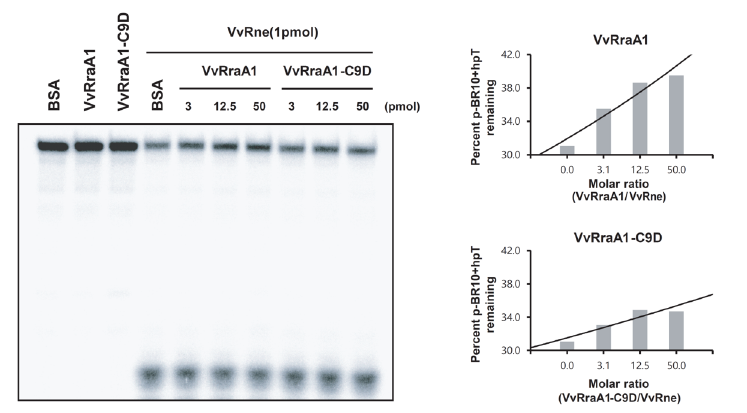
Fig 5. Inhibition of VvRraA1 and VvRraA1-C9D on the cleavage of p-BR10+hpT by VvRNase E in vitro . 0.5 pmol of 5’-end-labeled p-BR10+hpT RNA was incubated with 1 pmol of VvRne with varying concentrations of VvRraA1 and VvRraA1-C9D, 50 pmol of VvRraA1, or 50 pmol of BSA in 20 μ l of 1 × cleavage buffer at 37˚C for 2 h for VvRne, VvRraA1 only, or BSA only controls. Samples were mixed with an equal volume of loading buffer, and then denatured at 65˚C for 5 min and loaded onto a 12% polyacrylamide gel containing 8 M urea. The percentage of uncleaved p-BR10 +hpT in the gel was quantitated using a phosphorimager and OptiQuant software.